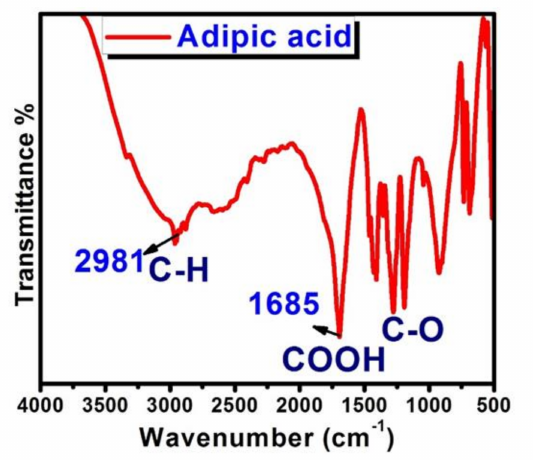
Figure 9. FTIR spectrum of synthesized adipic